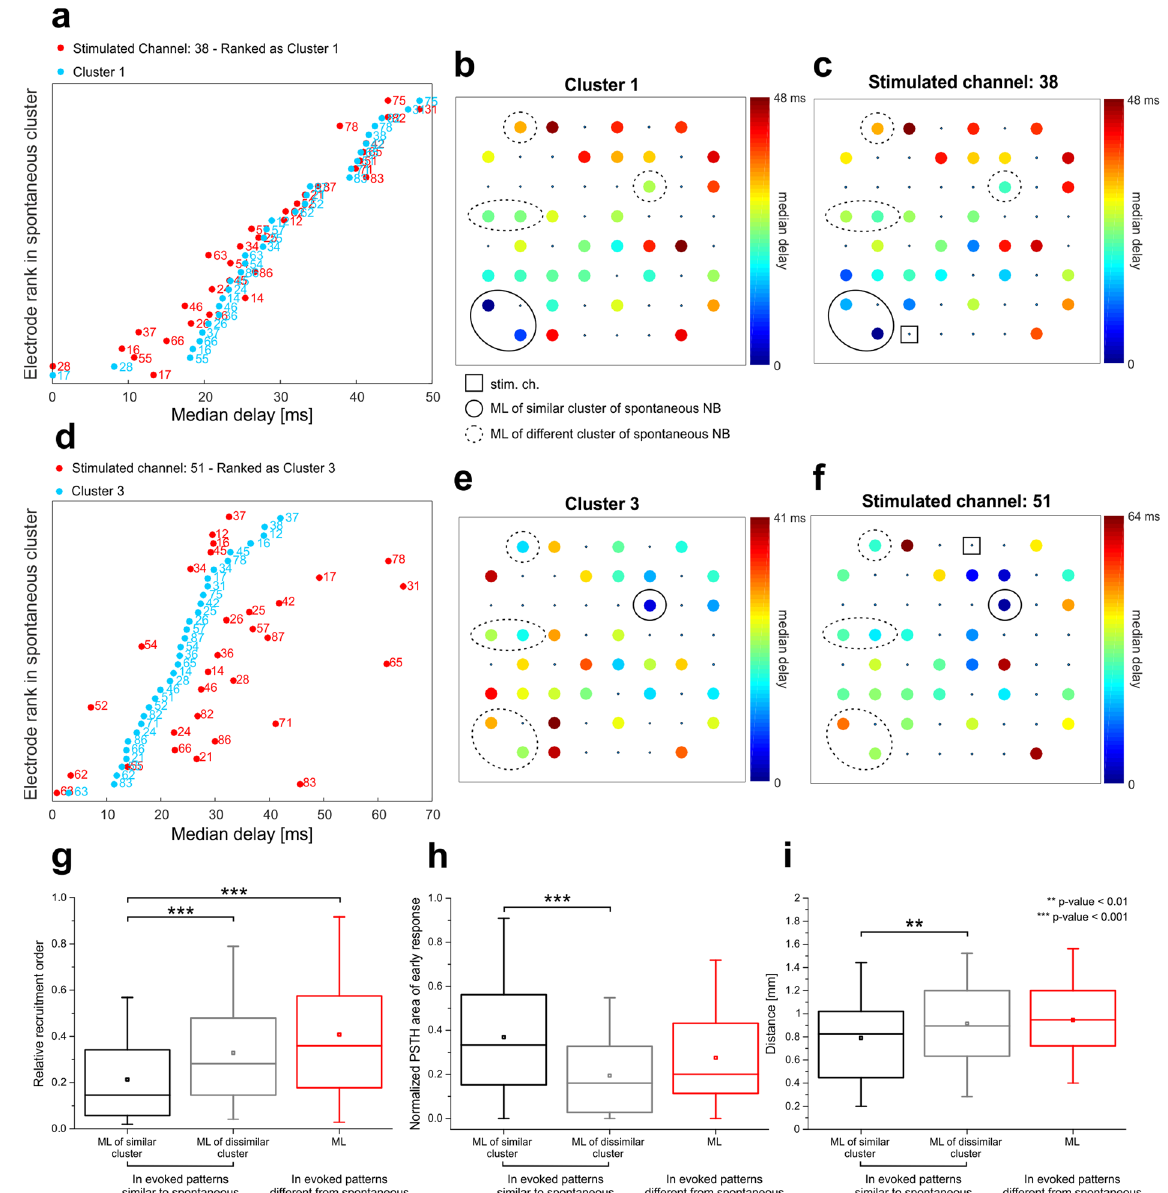
Figure 6. ML prompt and direct activation is predictive of pattern similarity. ( a , d ) Median delays of activation for two different stimulated electrodes (in red) and the associated similar spontaneous pattern (in light blue, same experiment as in Fig. 5a). For each electrode (on the y-axis) we reported the median delay of the first spike with respect to either the stimulation onset or the first activated electrode (on the x-axis). Electrodes, identified by a label according to the MEA layout (cf. Fig. 1), are sorted based on the rank order of median delays observed in the spontaneous cluster. ( b , c,e,f ) Color-coded maps of the median propagation delays of electrode activations (with respect to either the stimulation onset or the first activated electrode) for the same two stimulated electrodes and the corresponding similar spontaneous pattern. Each color-map has been rescaled according to the maximum delay (in ms), as indicated in figure. MLs and the stimulated channel are highlighted as indicated in the legend. ( g ) Statistical distributions of relative recruitment order of MLs in evoked patterns. (Kruskal- Wallis ANOVA on ranks with Dunn’s correction for pairwise multiple comparisons, p < 0.001). ( h ) Statistical distributions of normalized PSTH area of early response of MLs in evoked patterns. (Kruskal-Wallis ANOVA on ranks with Dunn’s correction for pairwise multiple comparisons, p < 0.001). ( i ) Statistical distributions of geometric distance of MLs from stimulated channels in evoked patterns (Kruskal-Wallis ANOVA on ranks with Dunn’s correction for pairwise multiple comparisons, p =